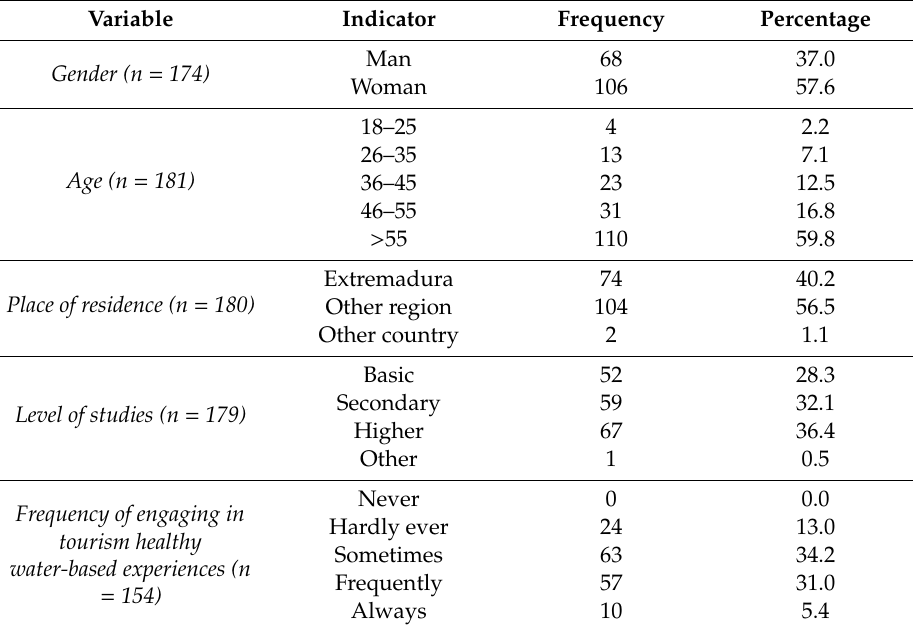
Table 2. Socio-demographic sample profile ( n =